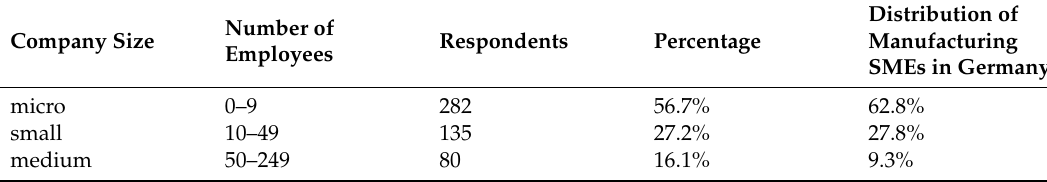
Figure 3. Energy demand of the surveyed SMEs. Table 3. Sample composition, according to